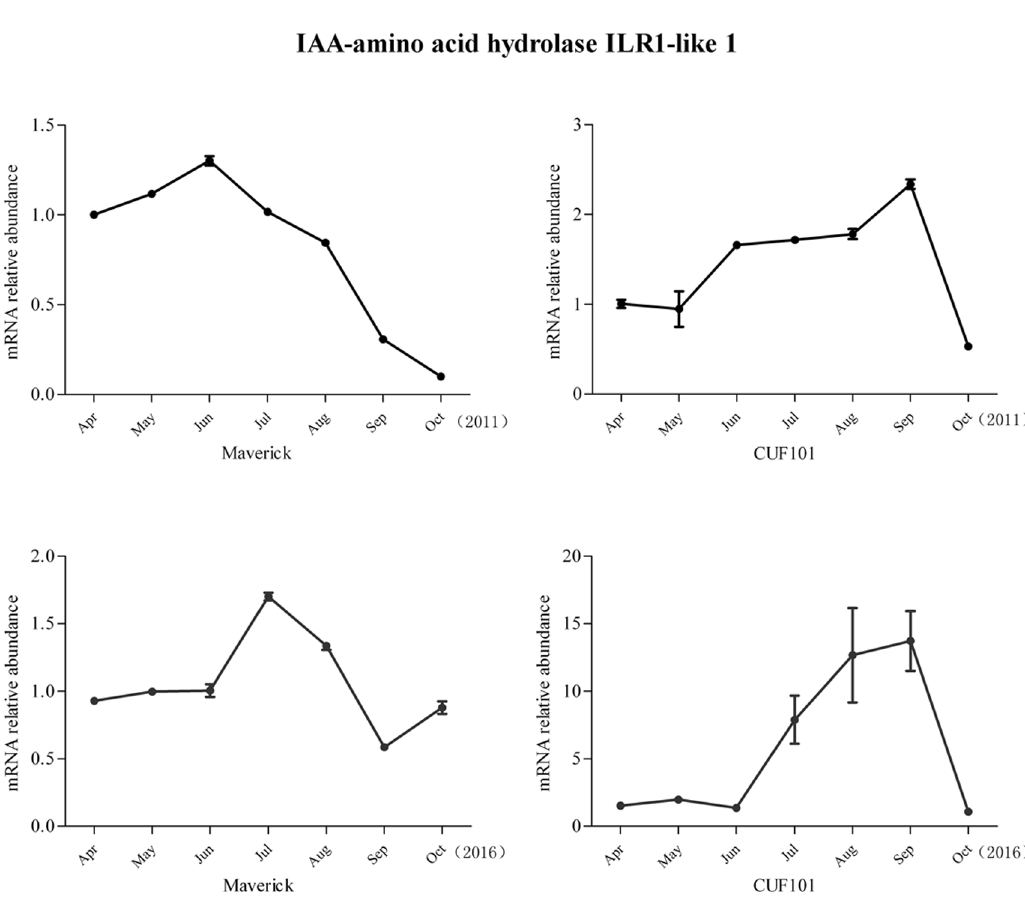
Fig 5. mRNA abundance of indoleacetic acid (IAA)-amino acid hydrolase ILR1-like 1 in Maverick and CUF101 varietiesfrom April to October in 2011and 2016. * and ** indicate significantdifference betweenAugust-September and June-Julyat p < 0.05 and p <